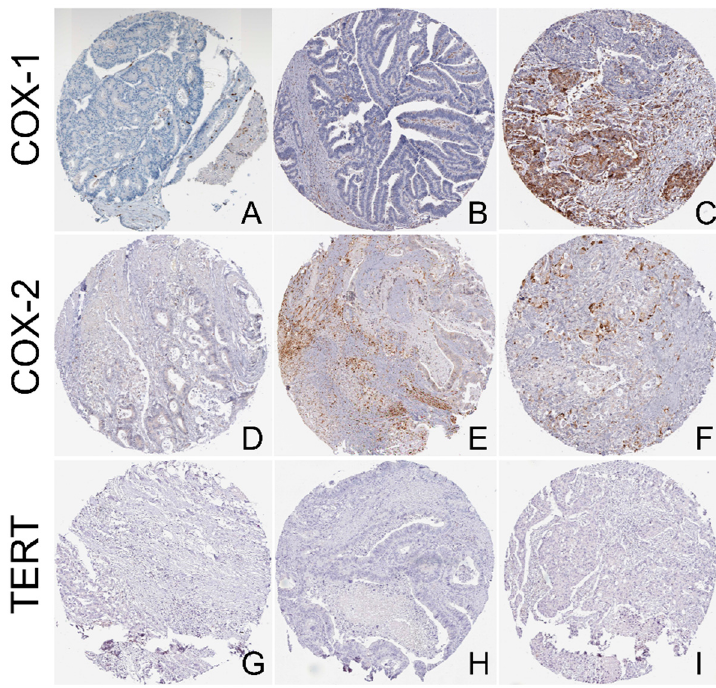
Figure 3. Representative tissue microarray (TMA) slides with COX-1, COX-2, and TERT-staining. ( A ) Negative COX-1 staining was detected in 4/10 (40%) CRC samples; ( B ) Low COX-1 staining was detected in 5/10 (50%) CRC samples; ( C ) Medium intensity COX-1 staining was detected in 1/10 (10%) CRC samples; ( D ) Negative COX-2 staining was detected in 7/12 CRC samples (58.3%); ( E ) Low COX-2 staining was detected in 4/12 CRC samples (33%); ( F ) Medium COX-2 staining was detected in 1/12 (8.3%) CRC samples; TERT staining was negative in all CRC samples (11/11, 100%) ( G – I ). All slides were retrieved from the Human Protein Atlas (HPA). Magnification, ×100.